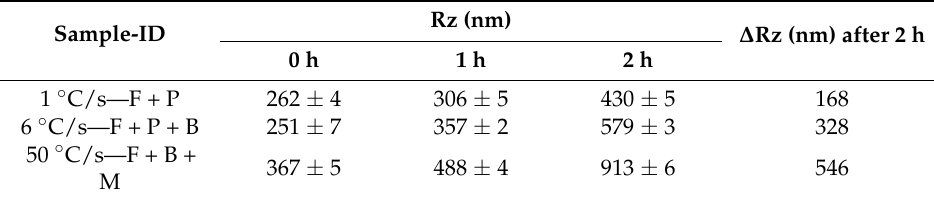
Table 2. Comparison of the effect of corrosion at different time on mean surface roughness depth (Rz) and ∆ Rz values after 2 h of corrosion in nano-scale for each microstructural